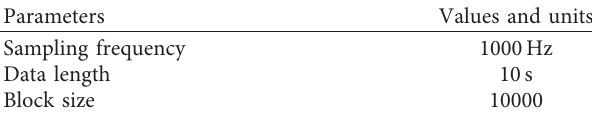
Table 3: Experimental parameters.